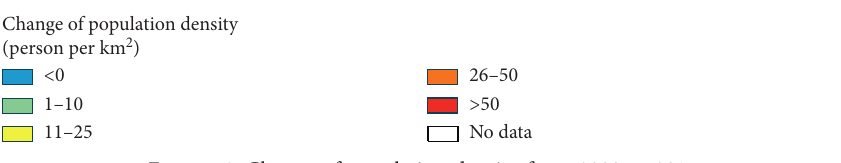
Figure 4: Change of population density from 2000 to